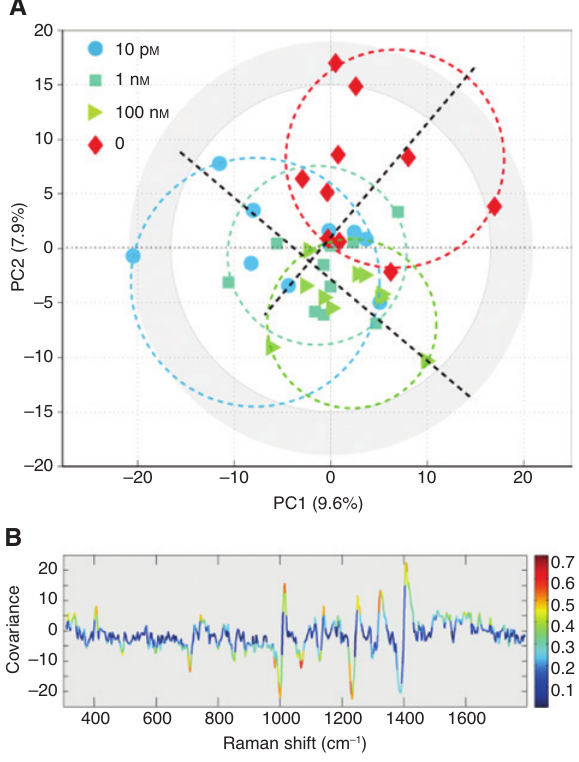
Figure 3: SERS spectral variations by adding MnSOD. (A) Score plot of PCA for 40 spectra. Concentrations corresponding to each symbol are indicated in the figure. Color dashed circles and dashed lines are guides to see a distribution of symbols and two axes of separation. (B) Covariance between spectral intensities and presence of MnSOD in a solution: 1 or 0 is added in the first row of each SERS spectrum when MnSOD is present or not present in the sample, respectively, and the covariance between the first row and spectral intensities at each wave number is shown in the figure. The color scale indicates correlation coefficient.